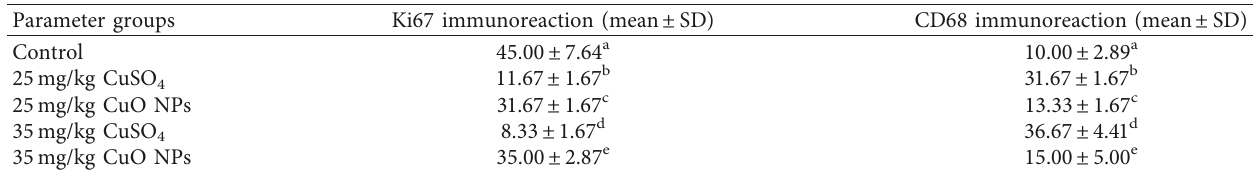
Table 2: The percentage of immunoreactivity of Ki67 and CD68 proteins in male mice testes induced by treatment with copper nanoparticles and copper sulphate.